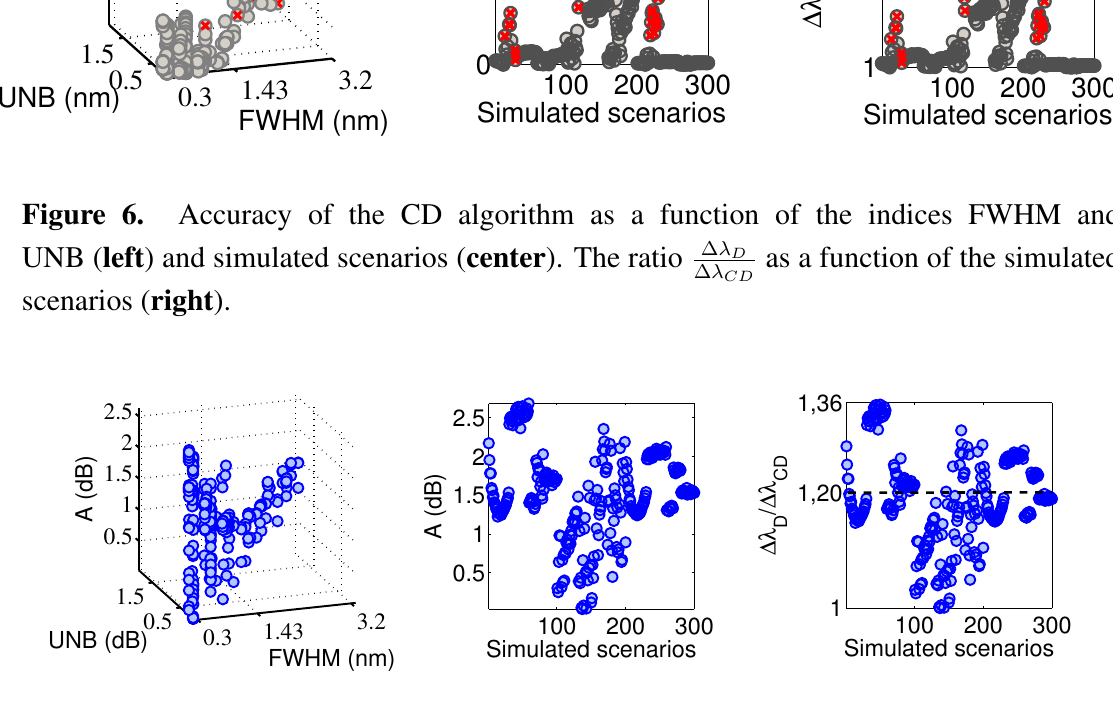
Figure 5. Accuracy of the maximum detection (MD) algorithm as a function of the indices, FWHM and UNB ( left ), and simulated scenarios ( center ). The ratio ∆ λ D of the simulated scenarios ( right ). The red crosses indicate the scenarios for which the < 0 . SNR MD